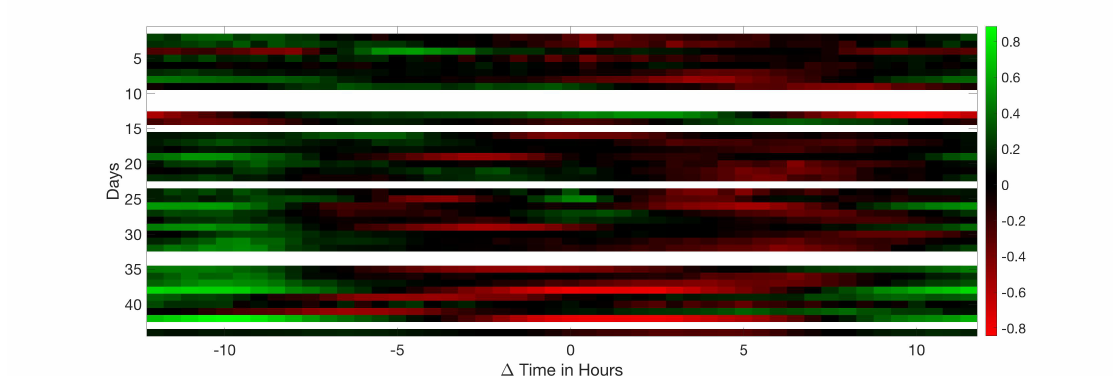
Figure 18. Results of the circular correlation humidity— L eq . Horizontal axis corresponds to the ∆ Time measured in hours, evaluating the delay between humidity and L eq . Vertical axis stands for the days of the cycle.